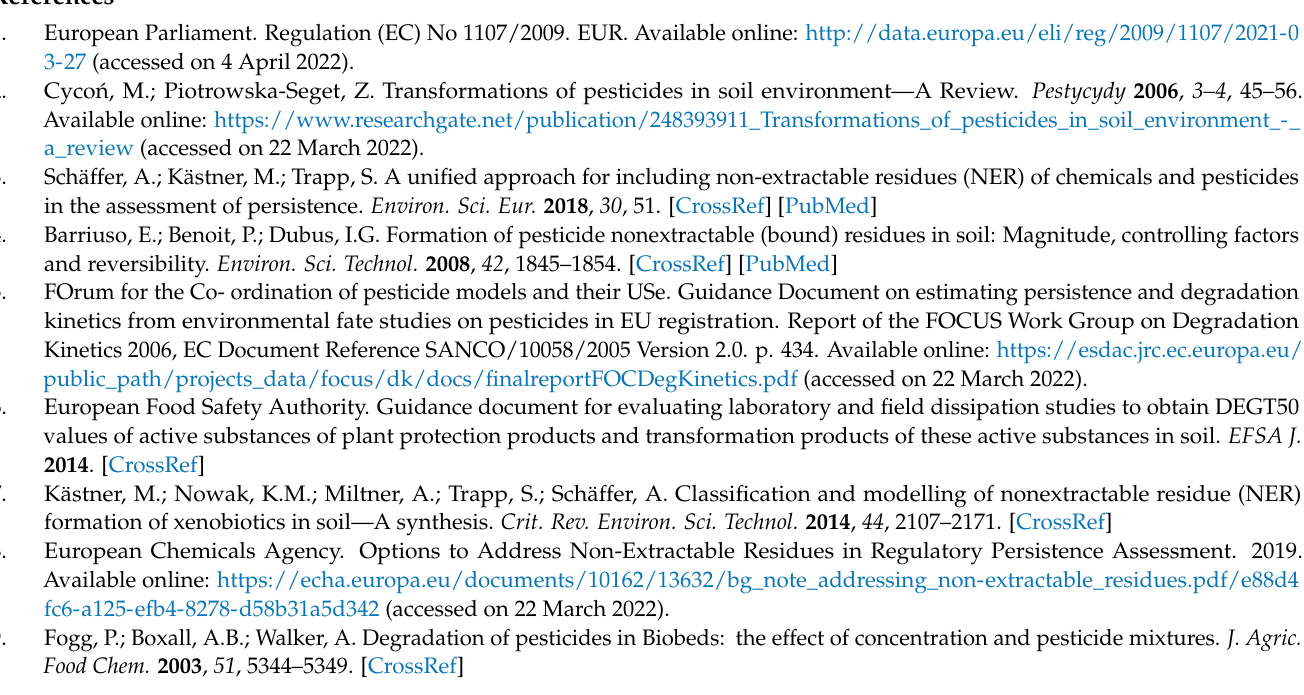
Table S5: Proportions of parent MCPA (% AR) in the CaCl 2 , MeOH, and SOX extracts in absence and presence of the fungicides on days 0, 7, and 14 for the different application scenarios as investigated by thin layer chromatography (TLC); Table S6: Results of the two-sample t -test for the extractable residues (ER) on days 0, 7, 14, 28, and 56; Table S7: Results of the two-sample t -test for the non- extractable residues (NER) on days 0, 7, 14, 28, and 56; Table S8: Results of the two-sample t -test for the mineralization (MIN) on days 0, 7, 14, 28, and 56; Table S9: Statistics of the dissipation kinetics of MCPA for the controls and fungicide treatment scenarios; Table S10: One-phase exponential association of MCPA mineralization for the controls and fungicide treatment